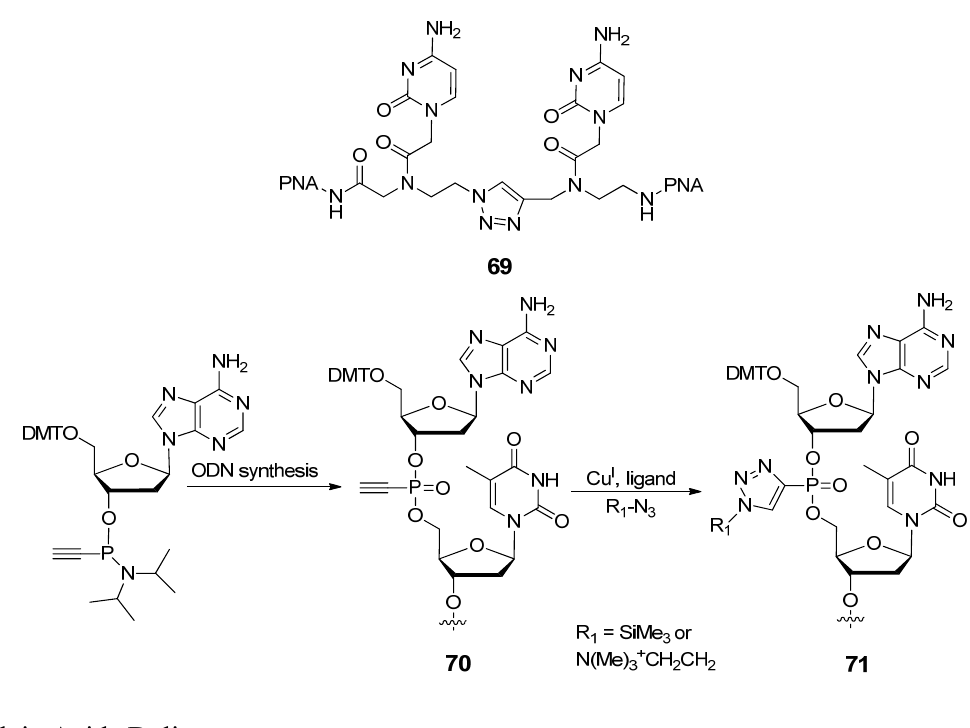
Figure 11. Synthesis of 1,2,3-triazolylphosphonate internucleotide (TP) linkages and the triazole-linked dimer within PNA.